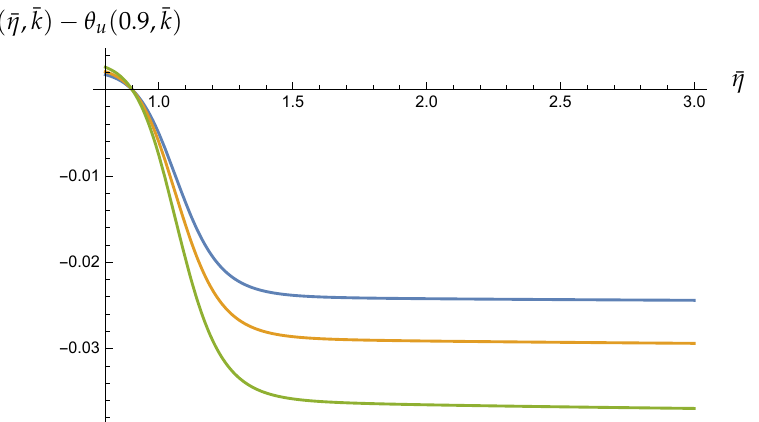
Figure A6. Plots of θ u ( ¯ η , ¯ k ) − θ u ( 0.9, ¯ k ) [rad] with ¯ k = e − 60 (blue), e − 50 (yellow) and e − 40 (green). θ U is the argument of U = U 0 + Γ U 1 . U 0 and U 1 are given by Equations (A5) and (A7), respectively. We also prescribe the rescaling of (A8) and (A9). Then, the plots of θ U ( ¯ η , ¯ k ) − θ U ( 0.9, ¯ k ) with ¯ k = e − 60 , e − 50 and e − 40 are shown in Figure A7. From these plots, we see that, except around ¯ η = 1.5, θ U is almost time-independent for e − 60 < ¯ k < e − 40 . θ U ( ¯ η , ¯ k ) − θ U ( 0.9, ¯ k )